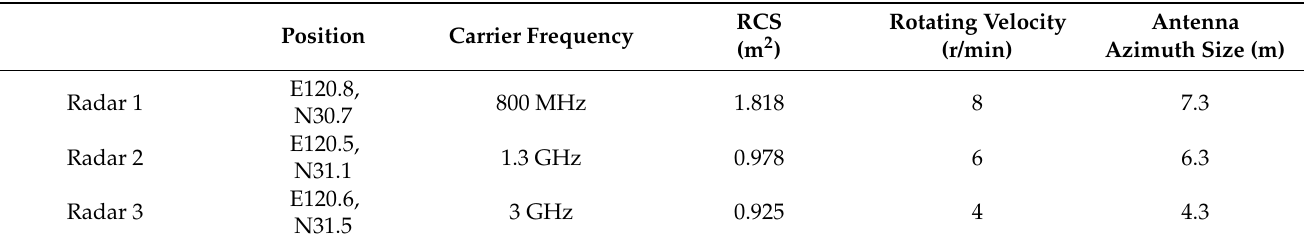
Table 1. Radar network parameters.